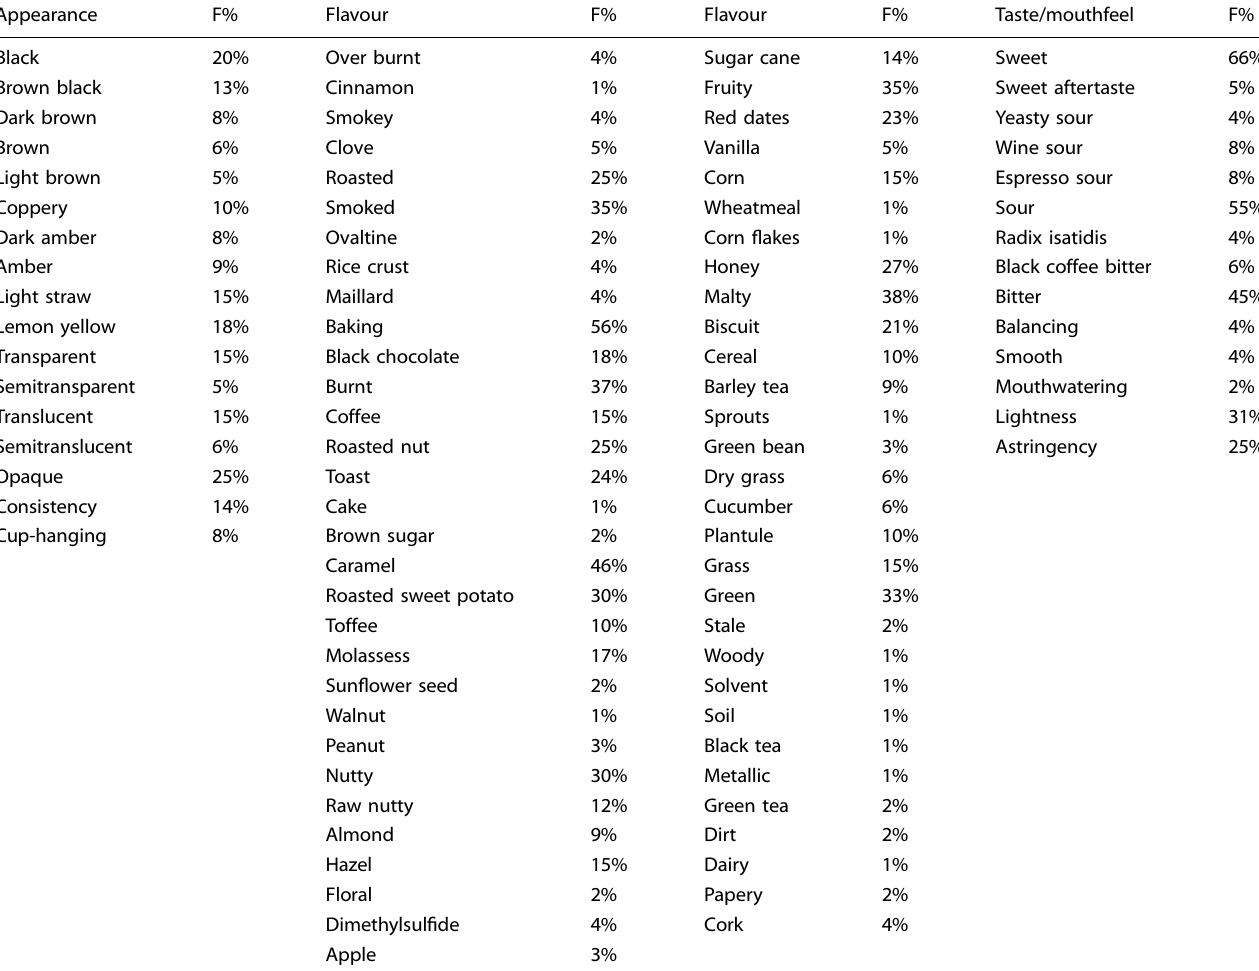
Table 1. Preliminary list of the descriptive terms generated by the sensory panel for the brewing malts and their usage frequency.